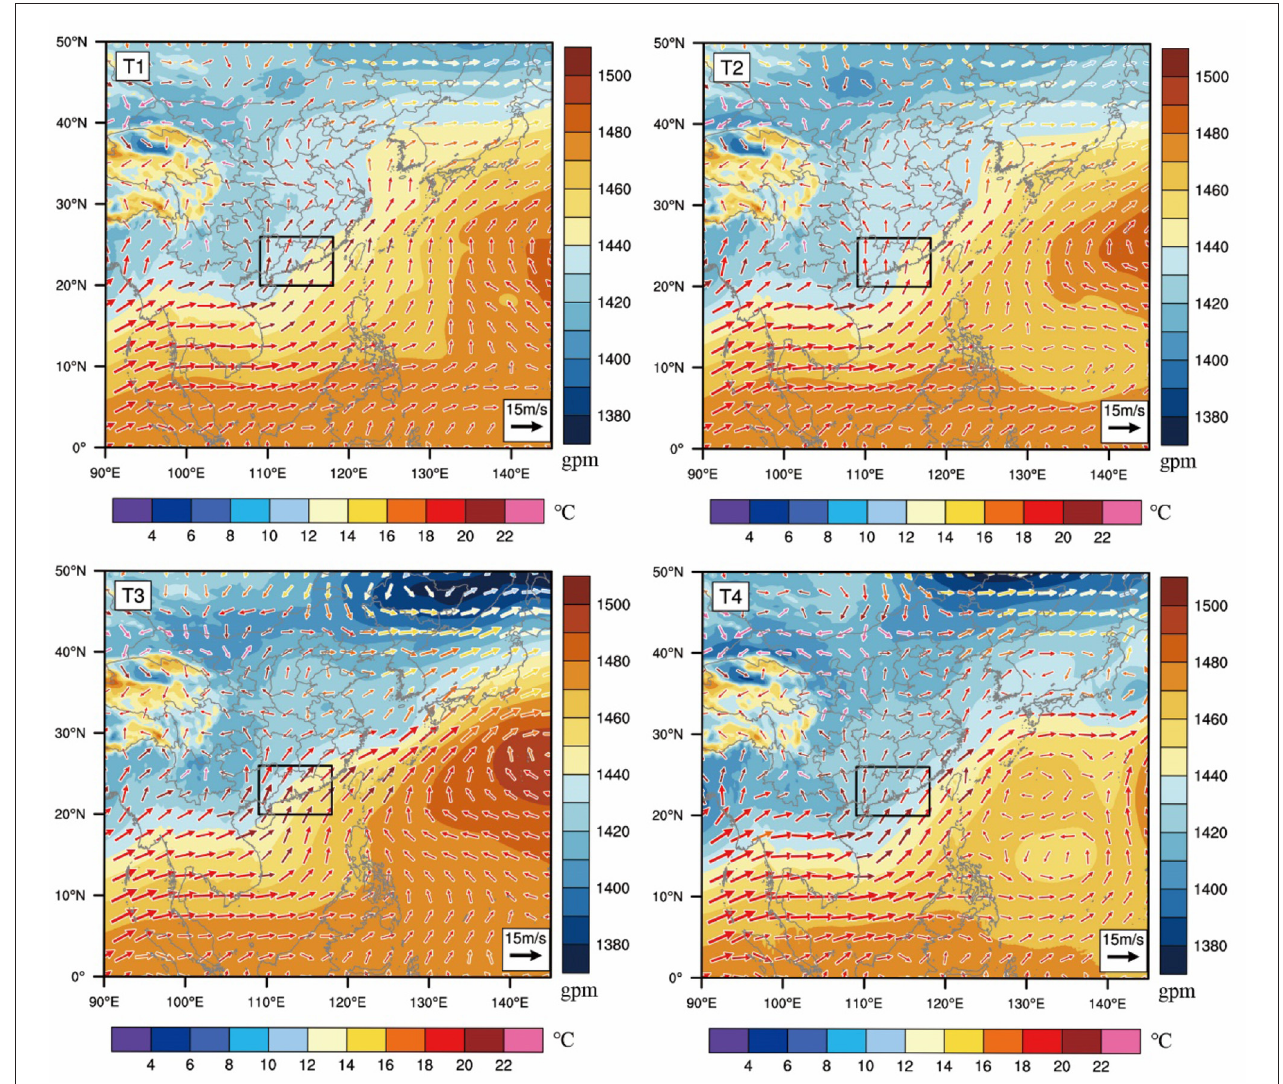
FIGURE 2 | The geopotential height (shaded) and 850 hPa wind with temperature (color vector) in four different weather types (T1–T4). The boxed area in panels encloses the